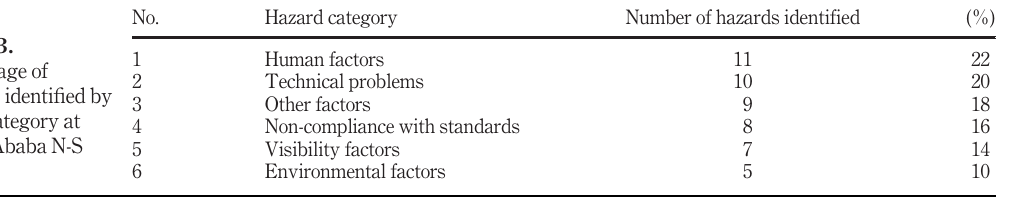
Table 4. Risk classi fi cation in percentages basing on the ALARP